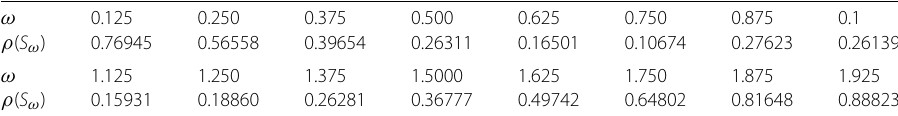
Table 2 The comparison results on the spectral radius of the SSOR iterative matrix of B for different ω ω 0.125 0.250 0.375 0.500 0.625 0.750 0.875 0.1 ρ ( S ω ) 0.76945 0.56558 0.39654 0.26311 0.16501 0.10674 0.27623 0.26139 ω 1.125 1.250 1.375 1.5000 1.625 1.750